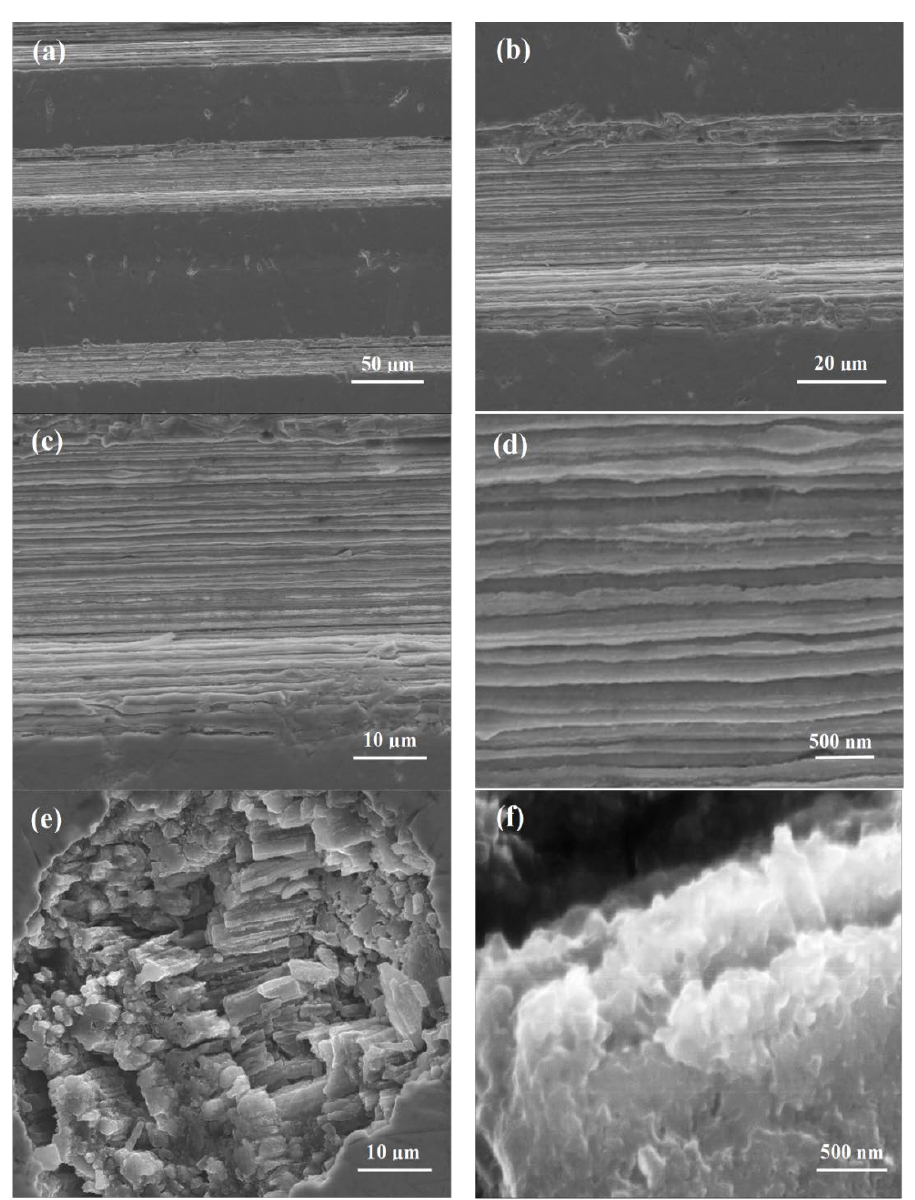
Figure 4. SEM photos ( a – d ) longitudinal-sections and ( e , f ) cross-sections for sample B annealed at 700 °C under isostatic pressure of 1.0 GPa for 15 min. at 700 ◦ C under isostatic pressure of 1.0 GPa for 15